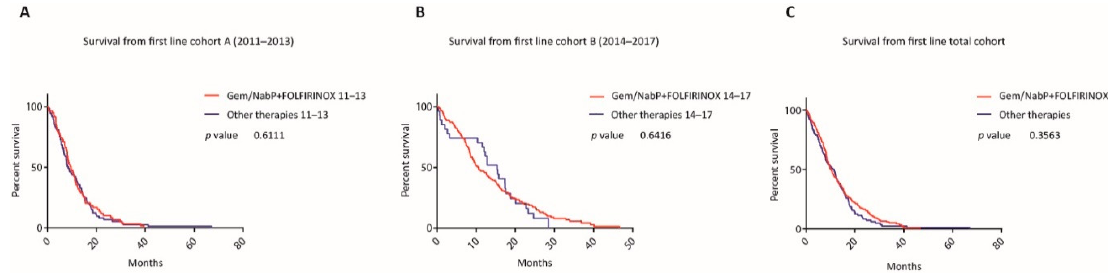
Figure 5. Survival with most popular first line regimens versus all other therapies within the two time periods. Kaplan-Meier curves of patients who started a first line therapy with either one of the two regimens gemcitabine/nab-paclitaxel and mFOLFIRINOX compared to all other therapies between 2011–2013 ( A ), 2014–2017 ( B ), as well as for the whole time period ( C ).